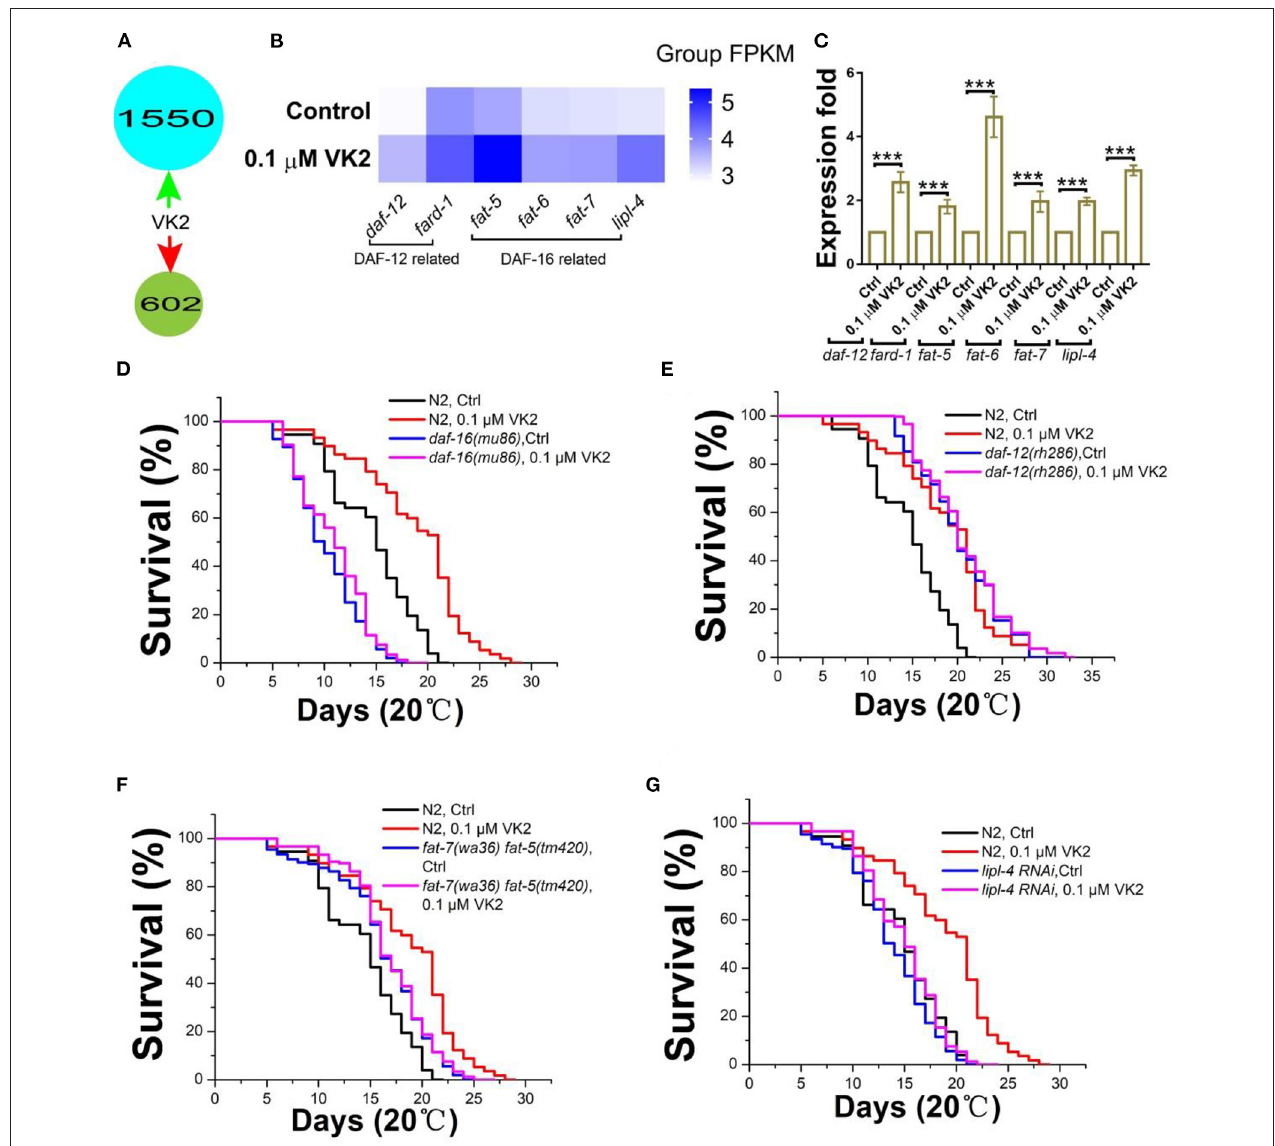
FIGURE 2 | Longevity extension conferred by VK2 treatment in N2 worms is related to the DAF-16/12 target genes. (A) RNA-seq data indicate genes up- and down-regulated subsequent to VK2 treatment in N2 worms. (B) KEGG pathway enrichment showed that the DAF-16/12-related longevity pathways were affected by VK2 treatment. Six target genes of DAF-16/12 were significantly up-regulated by VK2. The heat-map was made using Group FPKM for both control and VK2-treated worms. (C) The expression levels were further confirmed using real-time PCR. *** P < 0.001. (D) The lifespan extension conferred by the VK2 treatments was blocked by daf-16 (D) and daf-12 (E) mutants. The results were further confirmed using DAF-12/16 target gene mutants. VK2 failed to significantly extend the lifespan of fat-5/7 double mutants (F) . VK2 extended the lifespan of lipl-4 RNAi worms, but this was significantly shorter than in control worms (G) . The treatments were repeated at least three times, and the sample size was larger than 60 worms in each treatment. The data are summarized in Table 1 .